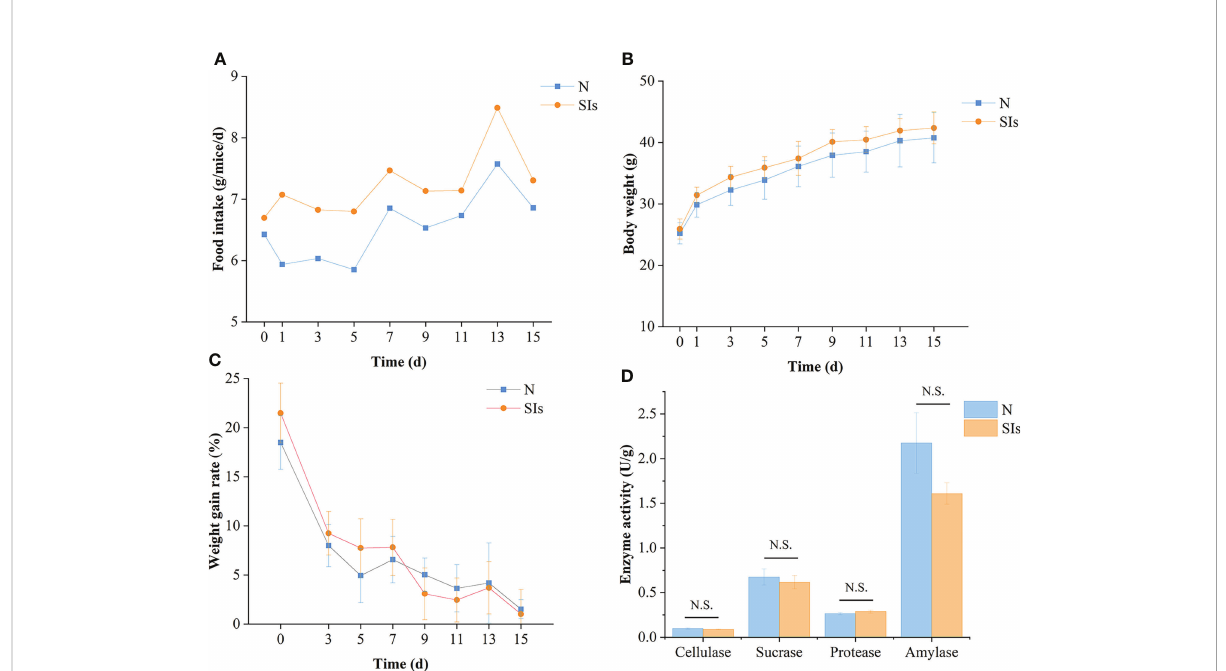
FIGURE 2 Effects of soybean iso fl avones on the growth and digestive enzyme activities of normal mice. (A) Food intake of mice ( n = 9). (B) Body weight of mice ( n = 9). (C) Weight gain rate of mice ( n = 9). Weight gain rate is the ratio of increment in weight and initial weight. (D) Digestive enzyme activities of mice ( n = 3). N, normal group; SIs, soybean iso fl avones group. In horizontal ordinate, 0 = the last day of acclimation. N.S., no signi fi cance ( P >